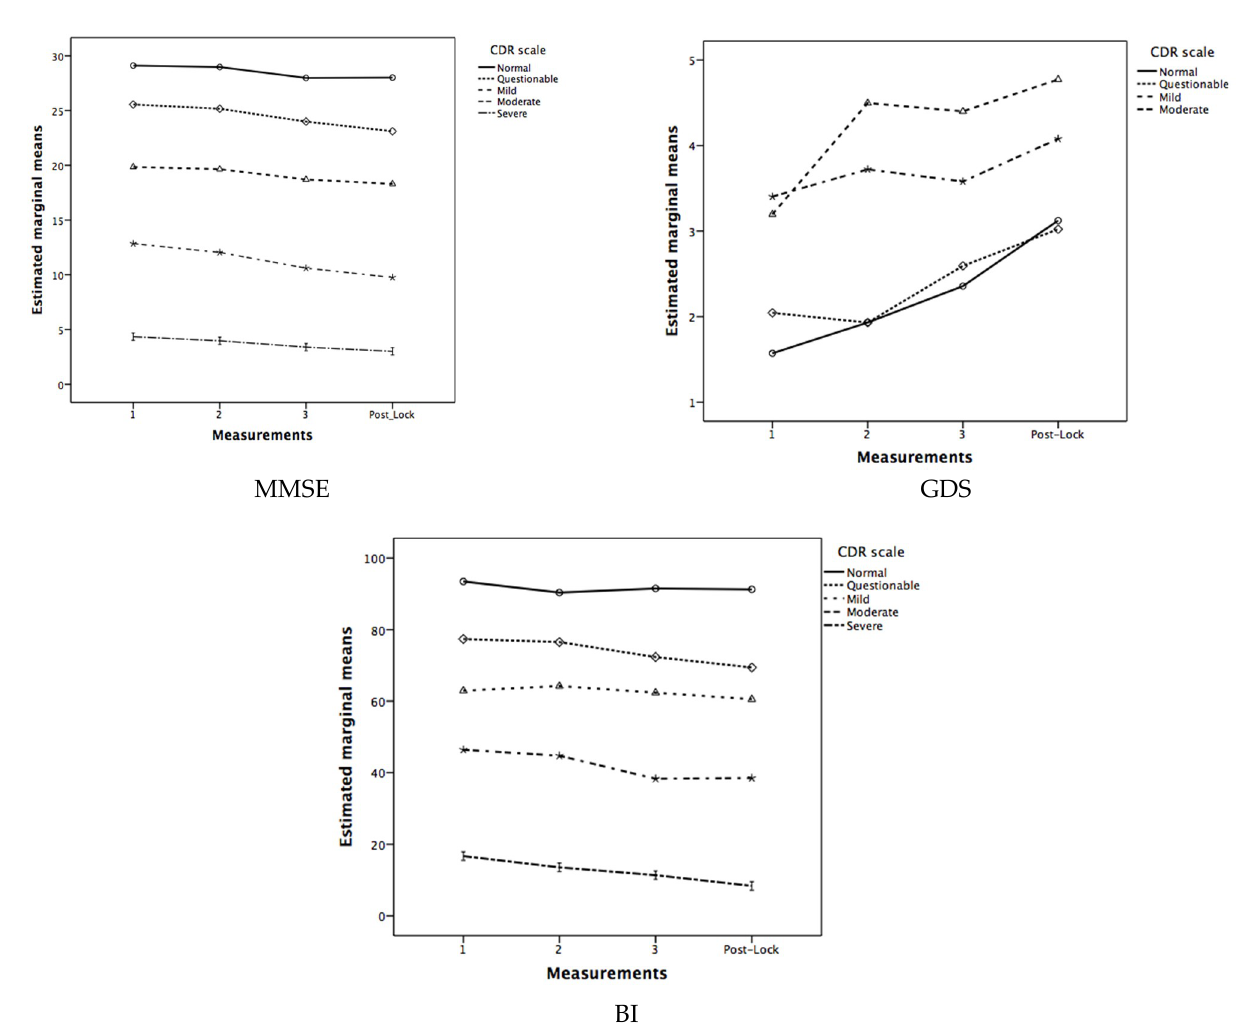
Figure 1. Estimated marginal means for the three pre-lockdown and the post-lockdown Mini-Mental State Examination (MMSE), Geriatric Depression Scale (GDS), and Barthel Index (BI) according to the Clinical Dementia Rating (CDR) levels, and with the social-contact frequency as a